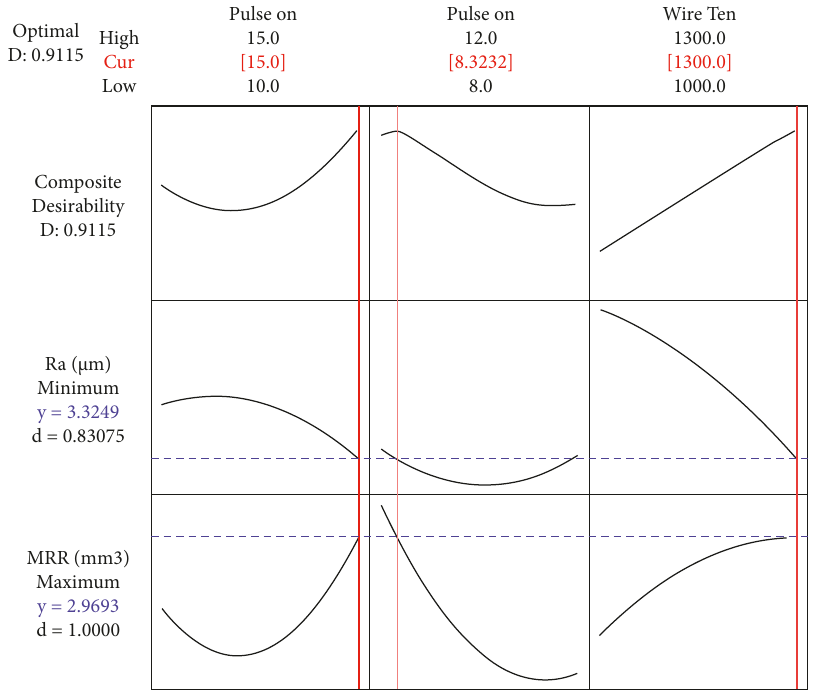
Figure 9: Multiobjective prediction MRR/Ra.